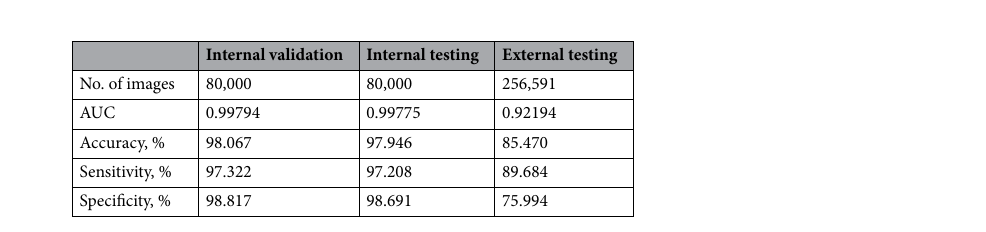
Table 3. Performance of binary classification model at each validation level. All performance outcomes were calculated when a cut-off value of 0.5 was applied.